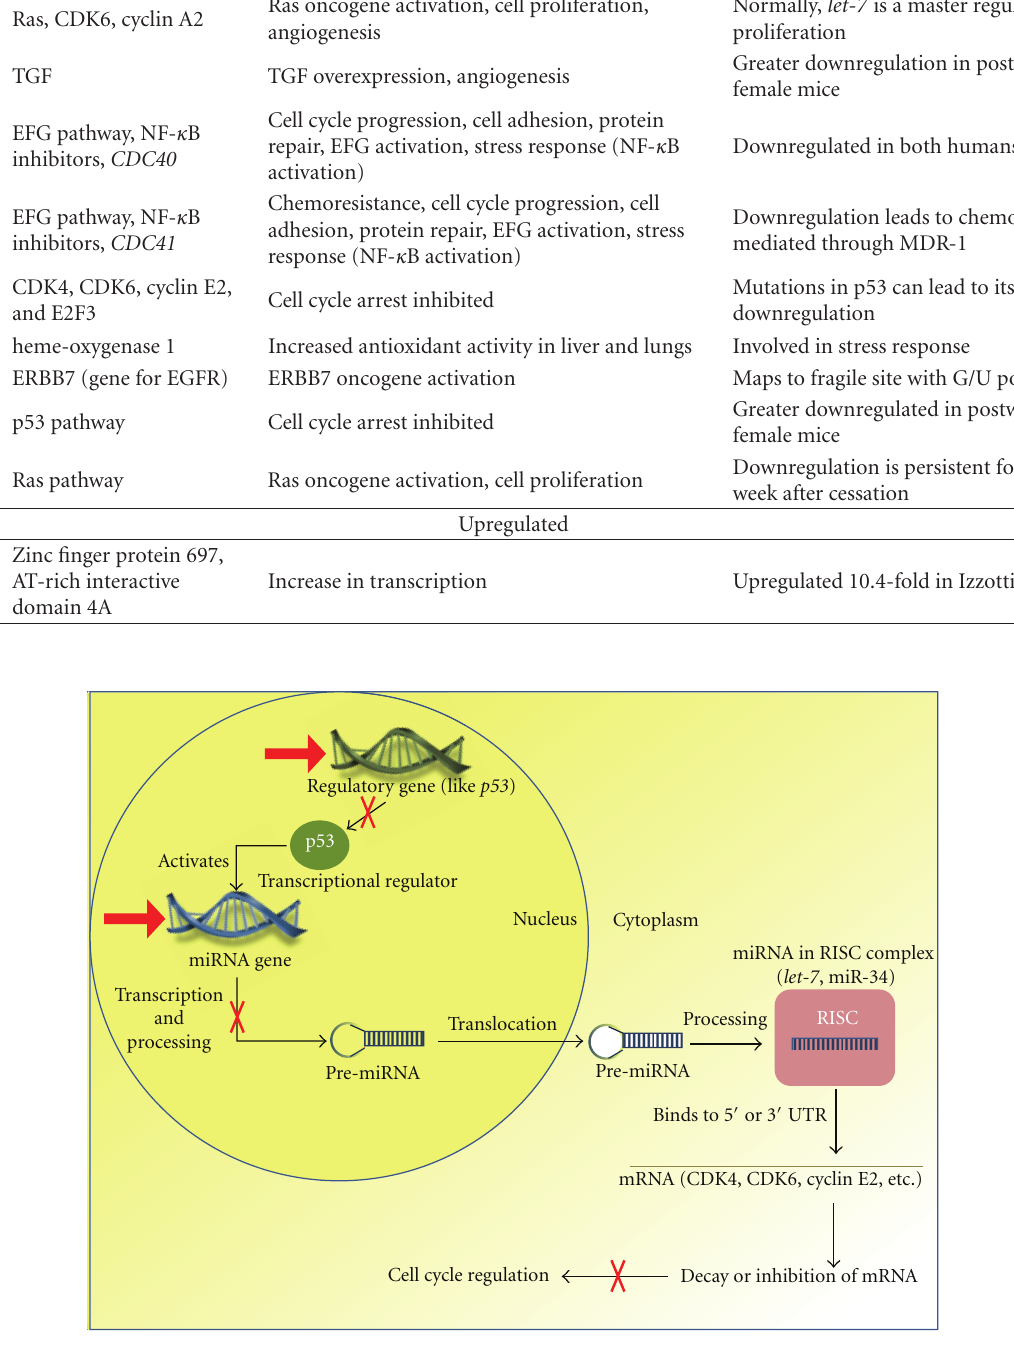
Figure 1: Simplified overview of the mechanisms by which cigarette smoke induces dysregulation of miRNA (red arrows) and subsequent carcinogenesis. CS can lead to genetic mutations in miRNA transcriptional regulators, like P53. Dysregulation of P53, an activator of miRNA transcription, leads to downregulation of miRNA, like miR-34. CS can also lead to epigenetic or genetic mutations in the miRNA gene itself, leading to dysregulation of transcription. Both downregulation and upregulation of miRNA can allow for cell proliferation if the miRNA is a tumor suppressor or oncogene, respectively. The red arrows indicate direct action of CS on miRNA production. The red “X’s” indicate inhibition of a normal process (indicated by black